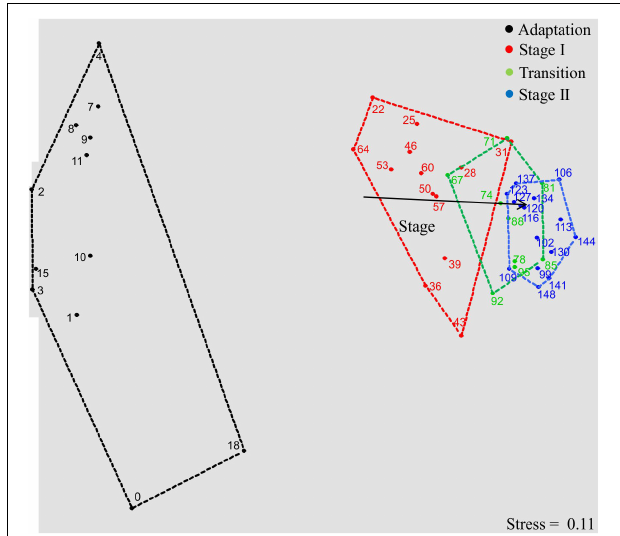
FIGURE 2 | Bacterial community dynamics in the four succession stages, illustrated by a non-metric multidimensional scaling (NMDS) plot of T-RFLP profiles (16S rRNA gene amplicons, restriction enzyme Rsa I; the plot based on Msp I is shown in Supplementary Figure S1 ). Data points are named according to sampling days. Proximity of data points represents community similarity based on the Bray-Curtis index. Colored polygons indicate sampling days of each process stage. The vector shows community shifts within the temporal dynamics ( P < 0.01, significance calculated by Monte-Carlo test with 999